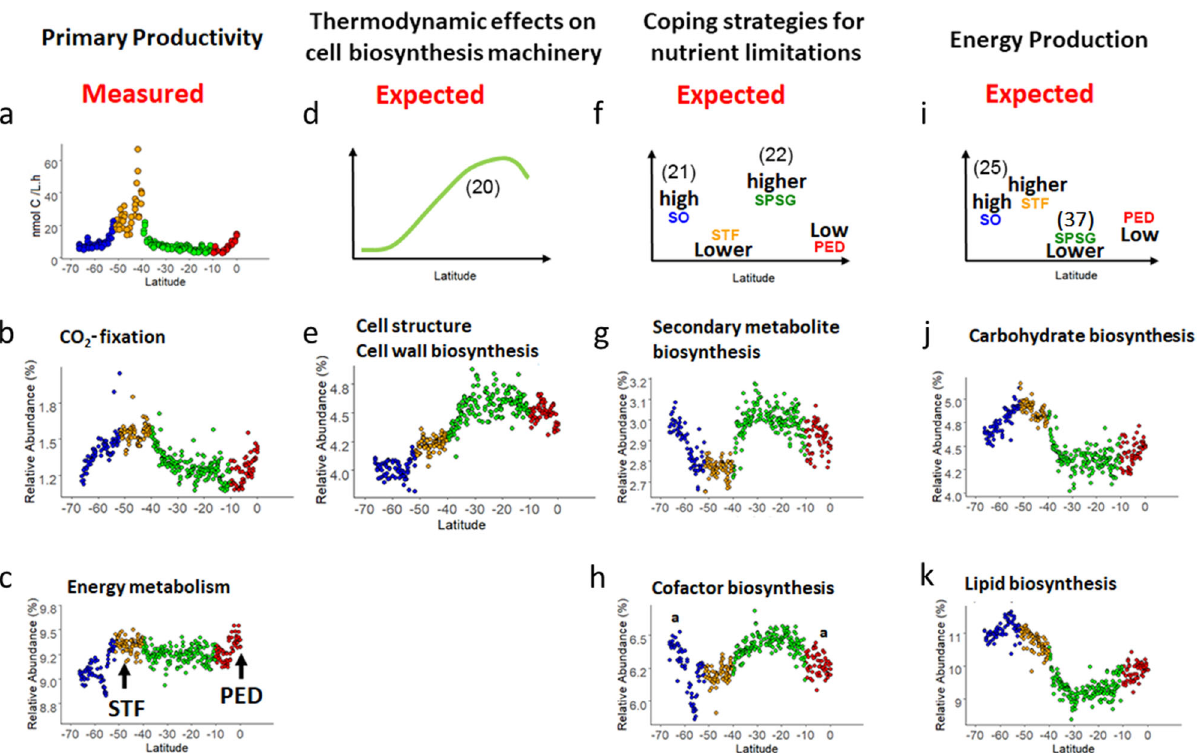
Fig. 4 Latitudinal trends for metabolic inferences from a 16S rRNA marker gene survey. Columns illustrate (from left to right) hypotheses and their associated secondary superclass (functional) pathways: H1 (PP), H2 (thermodynamic effects on cell biosystems machinery), H3 (coping strategies for nutrient limitation), and H4 (energy production). Graphs in the upper row illustrate measured data for PP ( a ) and expected values (according to the literature) for the processes relating to H2 ( d 20 ), H3 ( f 21 and 22 ), and H4 ( i 25 and 37 ). Graphs in the middle and lower rows show relative abundances of functional pathways predicted from 16S rRNA gene sequencing: CO 2 - fi xation ( b ), energy metabolism ( c ), cell structure and cell wall biosynthesis ( e ), secondary metabolite biosynthesis ( g ), cofactor biosynthesis ( h ), carbohydrate biosynthesis ( j ), and lipid biosynthesis pathways ( k ). The oceanographic provinces are color coded: the Southern Ocean (SO; blue), the Subtropical Frontal Zone (STF; orange), the South Paci fi c Subtropical Gyre Province (SPSG; green) and the Paci fi c Equatorial Divergence Province (PED; red). Signi fi cant differences were observed between provinces unless otherwise indicated by a